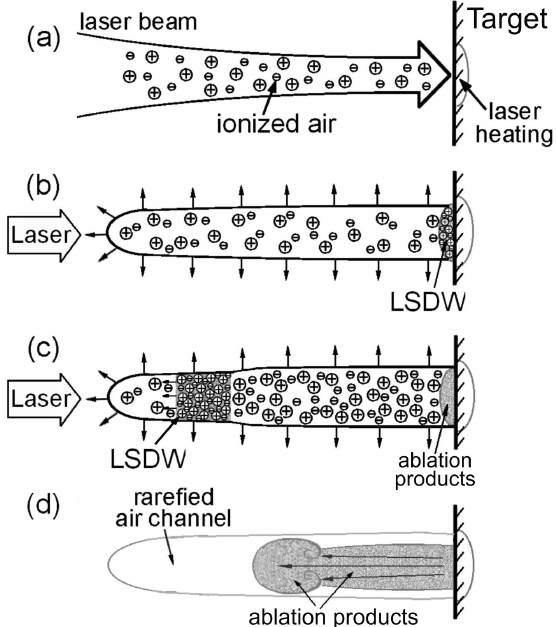
Figure 2. Schematics of plasma pipe formation and development under conditions of CO 2 laser ablation in air [14]. See explanation in